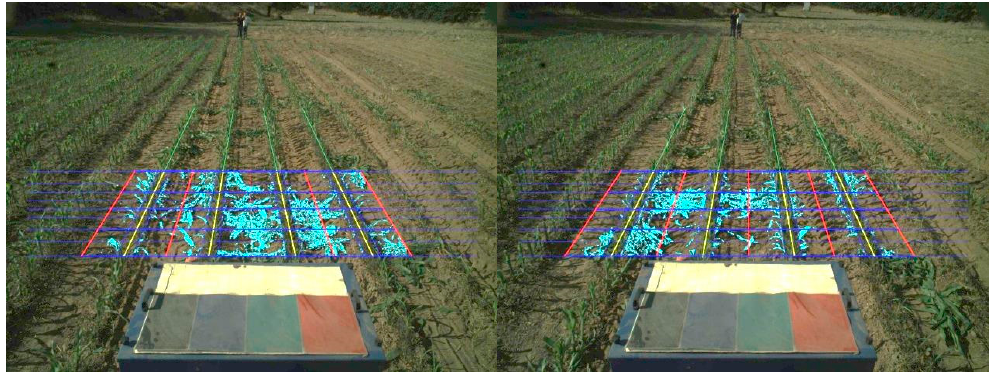
Figure 15. Consecutive images along a sub-path with the detected crop lines ( yellow ); parallel lines to the left and right crop lines ( red ); horizontal lines covering 0.25 m in the field. Images taken from [47].